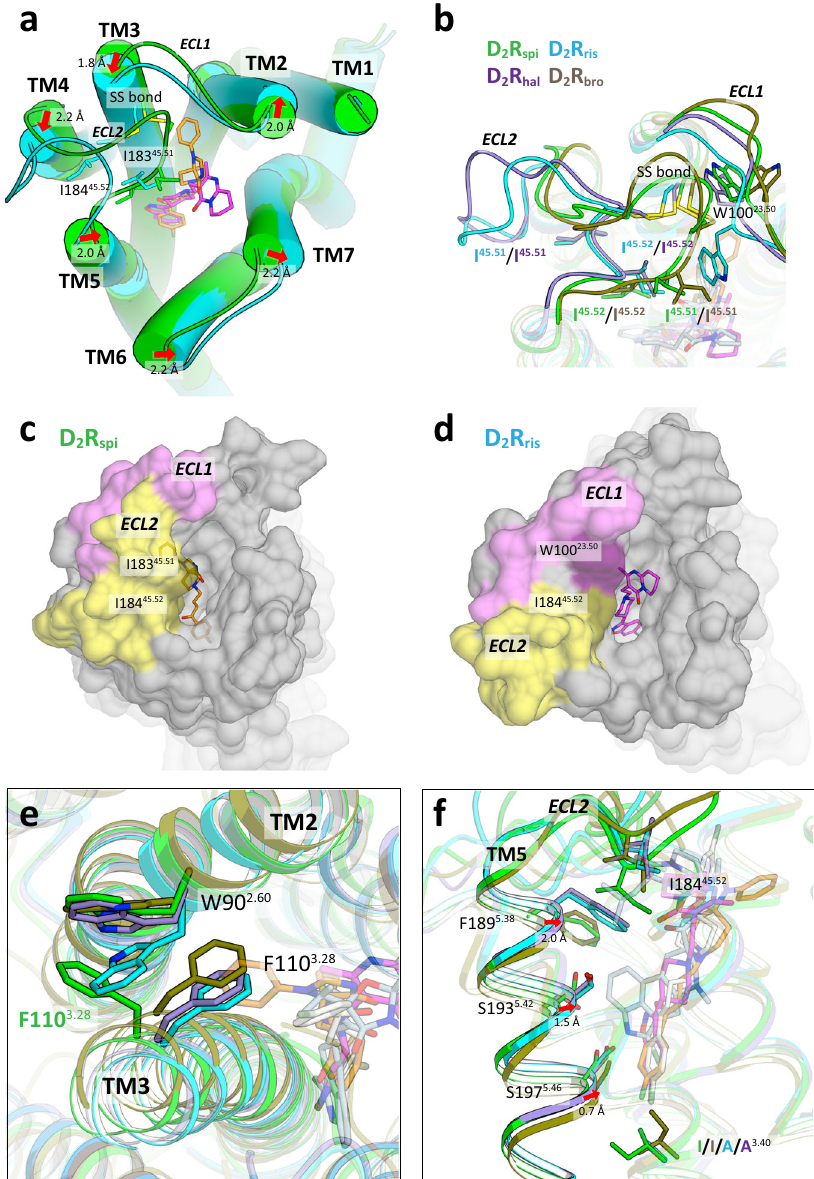
Fig. 3 Comparison of D 2 R structures. a Extracellular view of the superposition of D 2 R spi and D 2 R ris . The side chains of disul fi de bridge, I183 45.51 and I184 45.52 are shown as sticks. Red arrows indicate the shift of helices in D 2 R ris with the distance relative to D 2 R spi . b Extracellular view of ECL1 and ECL2 of D 2 R spi , D 2 R ris , D 2 R hal and D 2 R bro . The side chains of the disul fi de bridge, W100 23.50 , I183 45.51 , and I184 45.52 are shown as sticks. Surface representation of D 2 R spi ( c ) and D 2 R ris ( d ) viewed from the extracellular side. ECL1 and ECL2 are pink and yellow, respectively. e The EBP of D 2 R spi and the corresponding part of D 2 R ris , D 2 R hal and D 2 R bro . The side chains of W90 2.60 and F110 3.28 are shown as sticks. f Side view of the superposition of D 2 R spi , D 2 R ris , D 2 R hal and D 2 R bro around TM5 and ECL2. Red arrows indicate the shift of the extracellular half of TM5 in D 2 R ris and D 2 R hal relative to D 2 R spi . In ( b ), ( e ), and ( f ), D 2 R spi (green), D 2 R ris (cyan), D 2 R hal (purple), D 2 R bro (olive), spiperone (orange), risperidone (magenta), haloperidol (ivory), and bromocriptine (lightblue) are